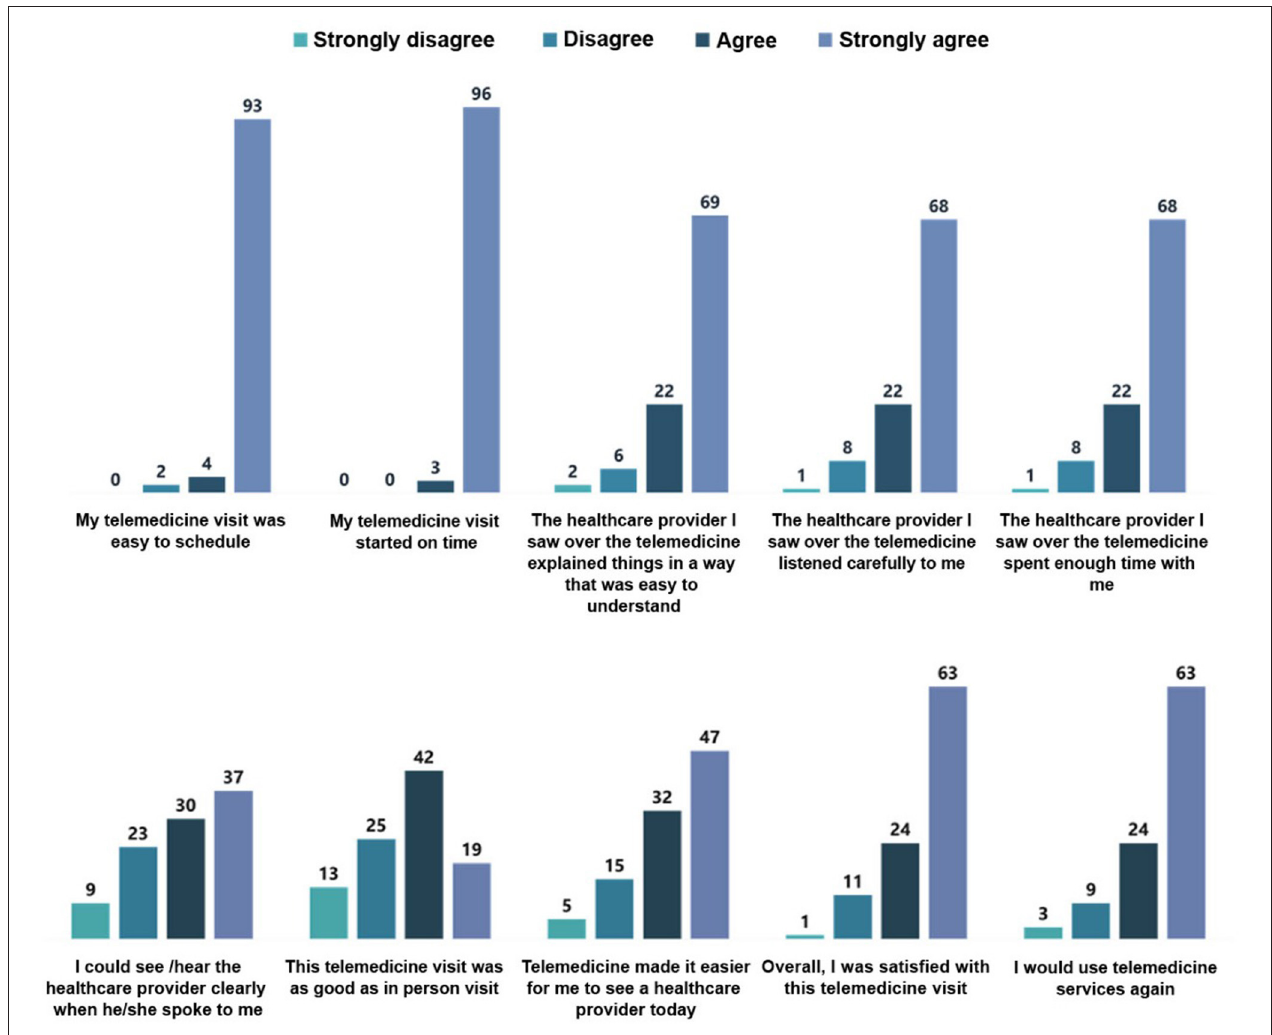
FIGURE 1 | Patient satisfaction